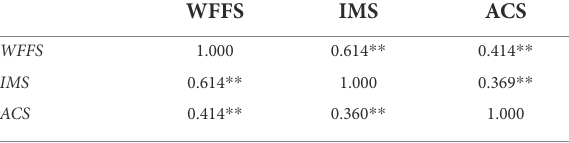
TABLE 7 Spearman’s rank correlations between. WFFS IMS ACS WFFS